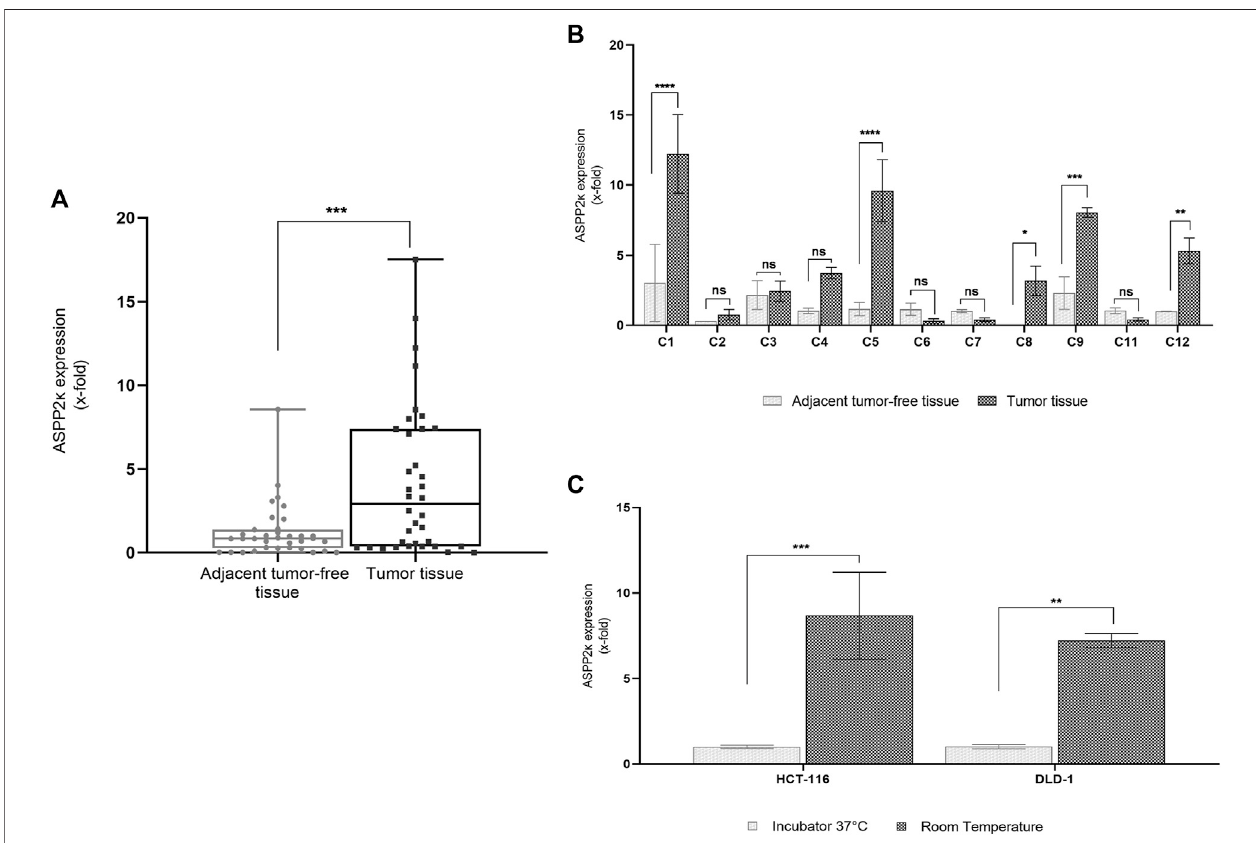
FIGURE 1 | (A) ASPP2 κ isoform-speci fi c qRT-PCR analysis determines relative mRNA expression levels in CRC tissue (n (cid:1) 15) compared to a pool of adjacent tumor-freetissuecolorectal tissue(n (cid:1) 14).Analysesperformedintriplicates. Statisticaltests: unpaired t -test (B) ASPP2 κ speci fi cqRT-PCRassaytocompareindividual ASPP2 κ expression levels in tumor tissue vs. adjacent tumor-free tissue colorectal tissue of the same patient. Statistical test: two-way ANOVA. Pair C10 was removed from analysis due to R1 resection status. (C) ASPP2 κ speci fi c qRT-PCR demonstrates temperature inducible expression of the splicing variant in CRC cell lines. Statistical test: two-way ANOVA. **** p < 0.0001, *** p < 0.001, ** p < 0.01, * p < 0.05, ns: not statistically signi fi cant.